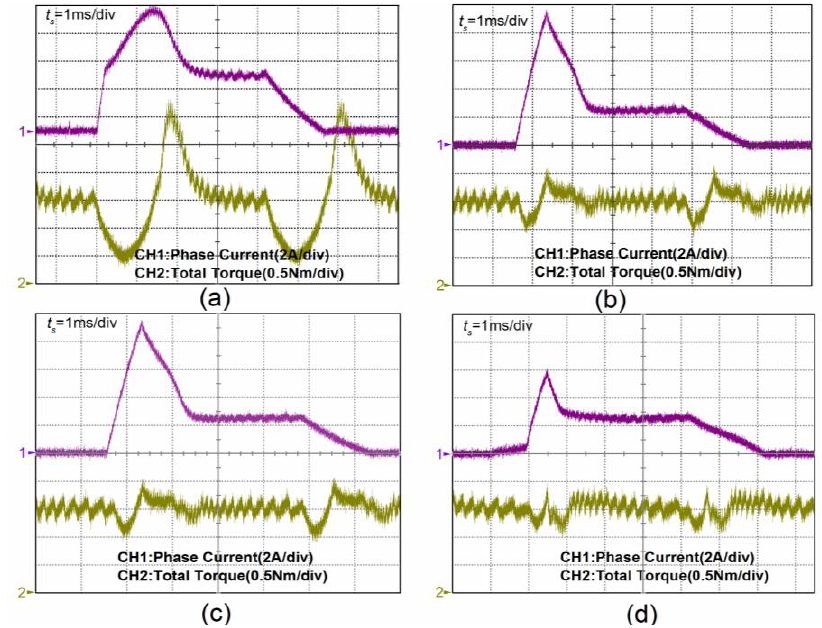
Figure 16. Experimental results (speed = 3000 rpm, T ref = 1.5 Nm): ( a ) CCC; ( b ) Linear TSF; ( c ) Sinusoidal TSF; ( d ) TSF1 ( r = 4).